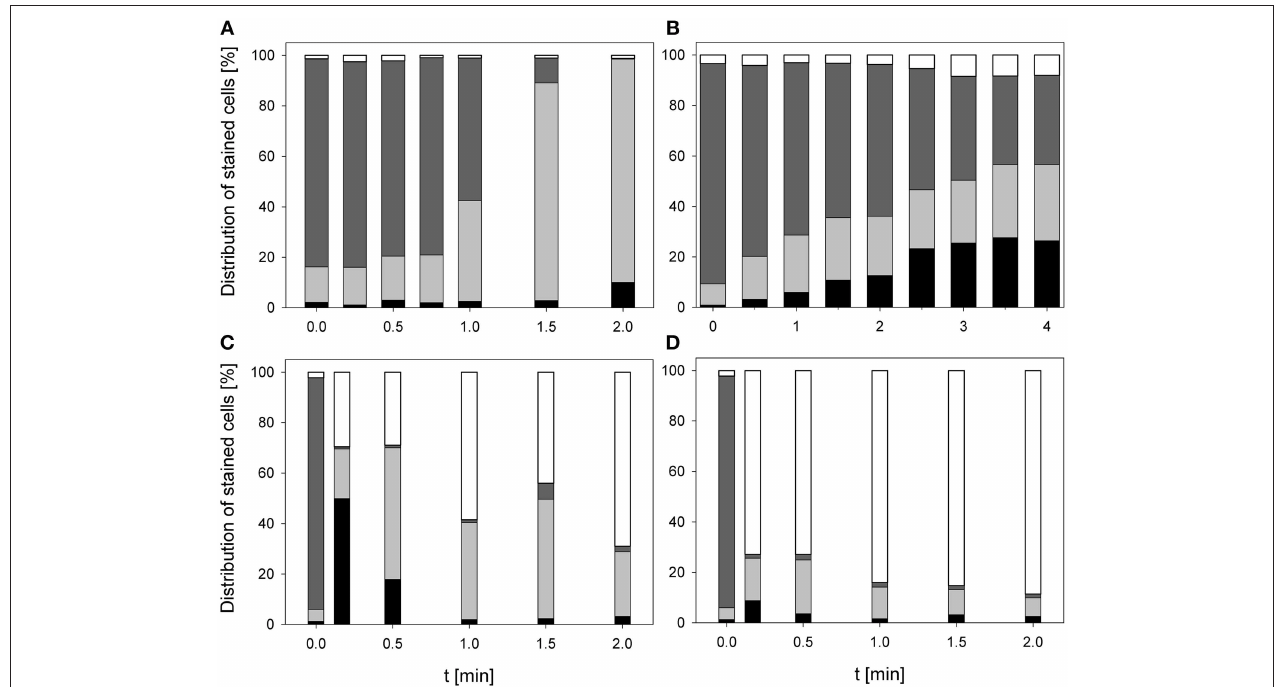
FIGURE 3 | Membrane integrity of E. coli after PAA treatment [(A) 10 ◦ C, 0.25% PAA], CAPP treatment [(B) 20 W), and treatment with ozonated water [(C) 3.8mg l − 1 O 3 (–); (D) 3.78mg l − 1 O 3 ( + )]. Black bars representing permeabilized cells; gray bars representing slightly permeabilized cells, light gray bar representing intact cells, and white bars representing cells without fluorescence/cell